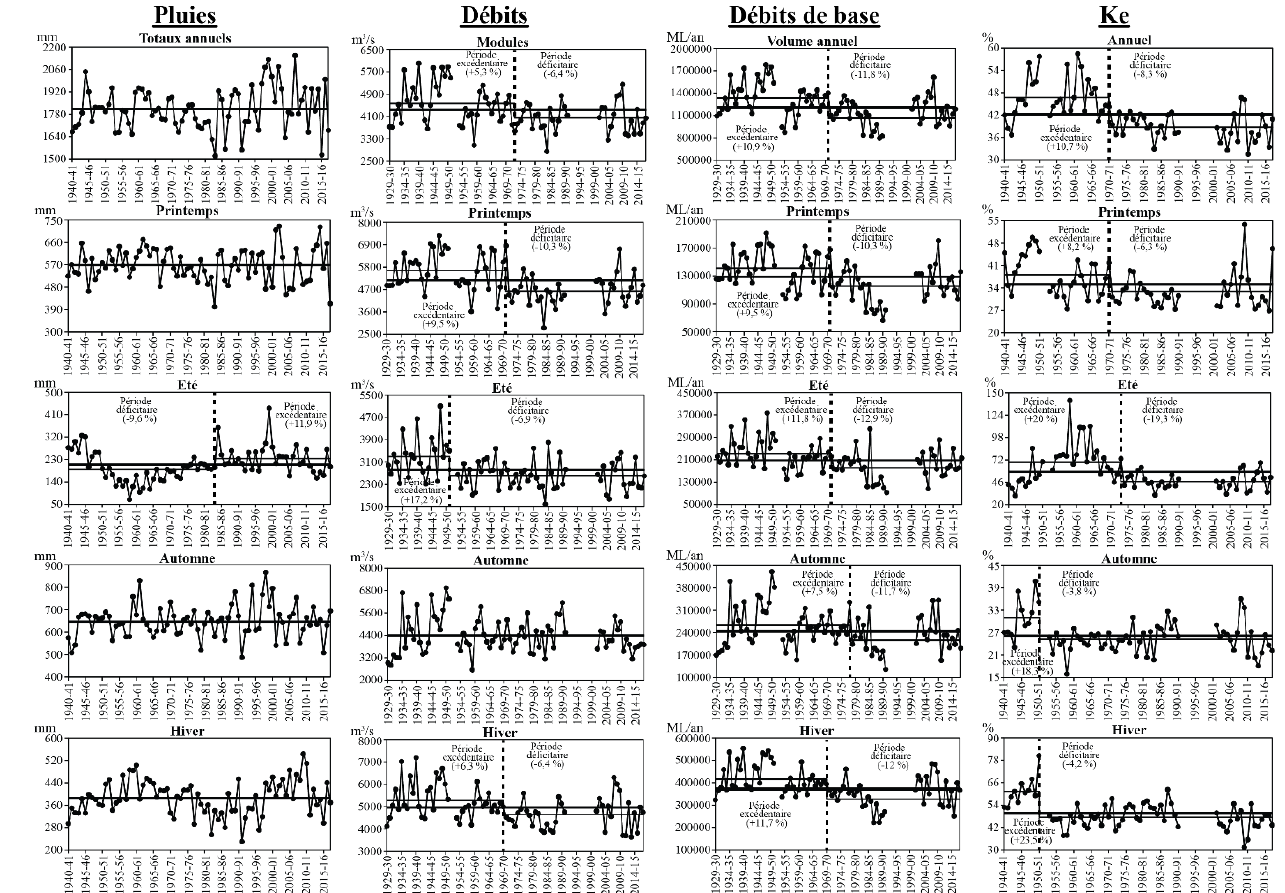
Figure 2. Evolution des pluies, débits, débits de base et coefficients d’écoulement annuels et saisonniers du bassin du l’Ogooué sur leurs périodes d’études